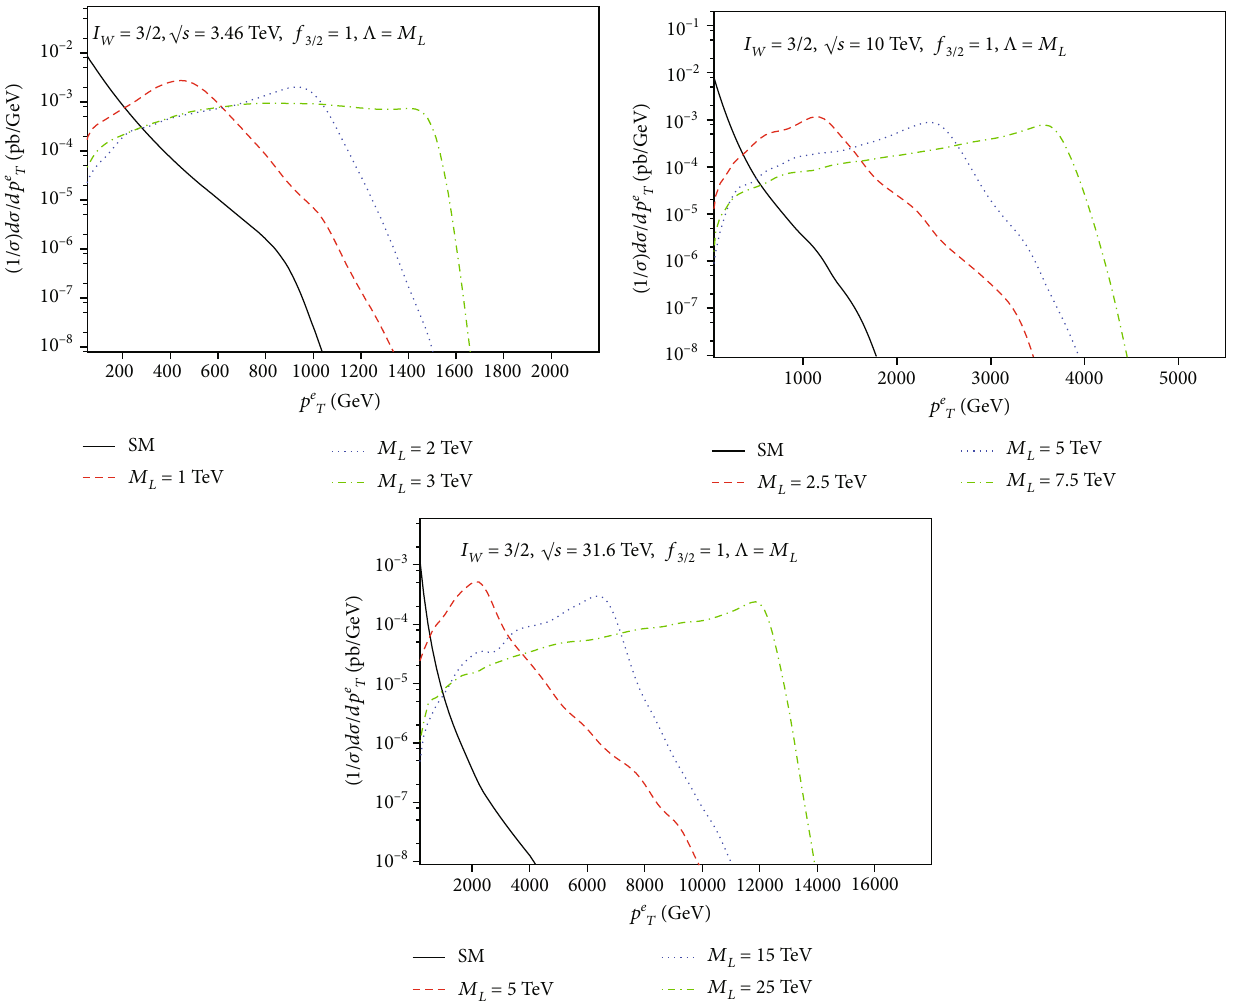
= 3/2 multiplet for f W